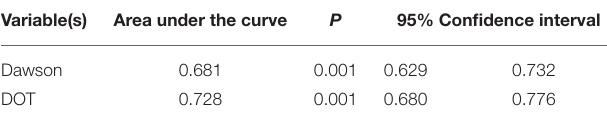
TABLE 5 | The area under the curve of the scores of TIA. Variable(s)